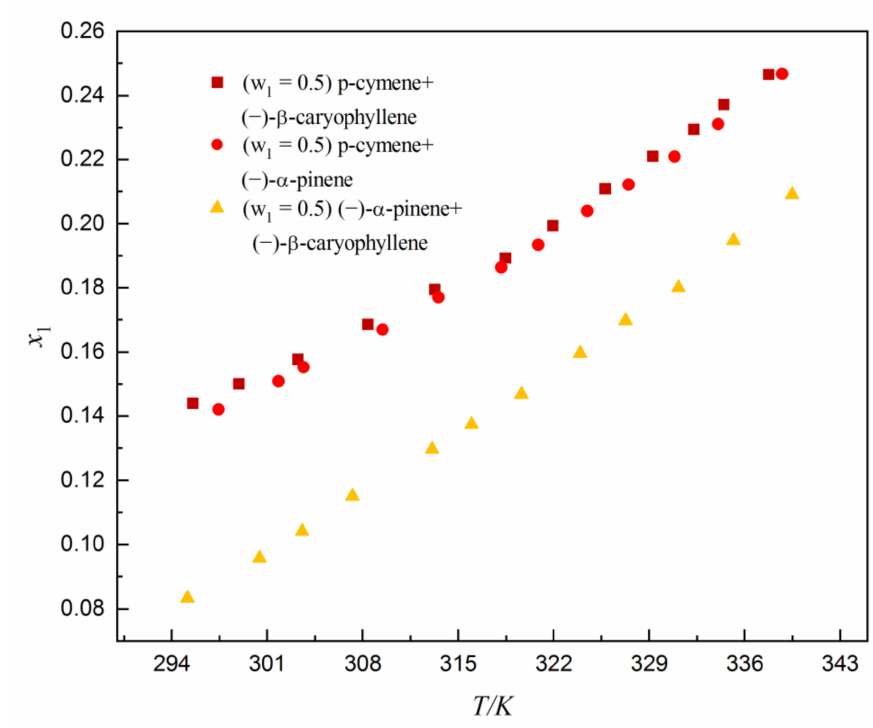
Figure 5. Mole fraction solubility of dehydroabietic acid in the three mixed solvents.